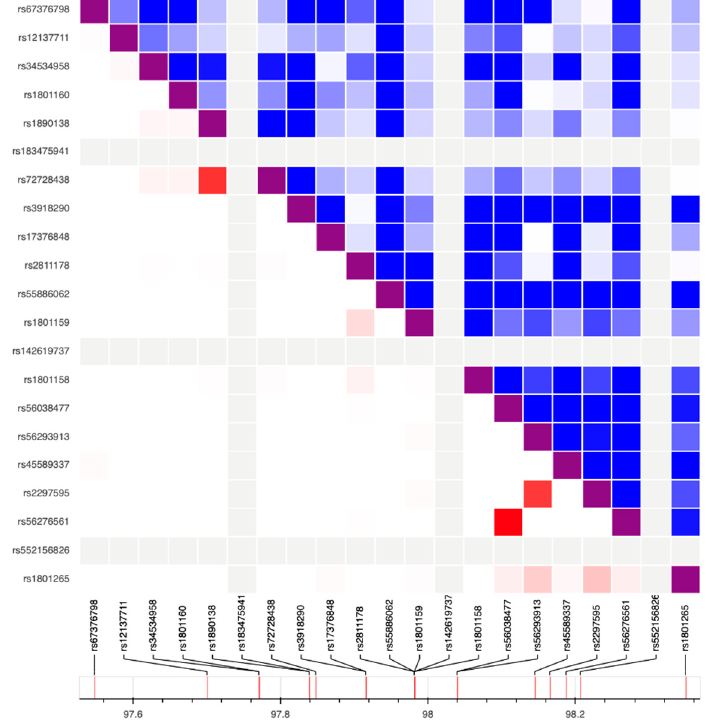
Figure 2. Heatmap matrix of pairwise linkage disequilibrium statistics.